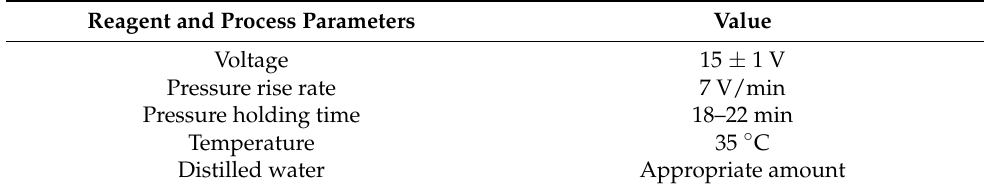
Table 3. Preparation process parameters of anodic oxide film.